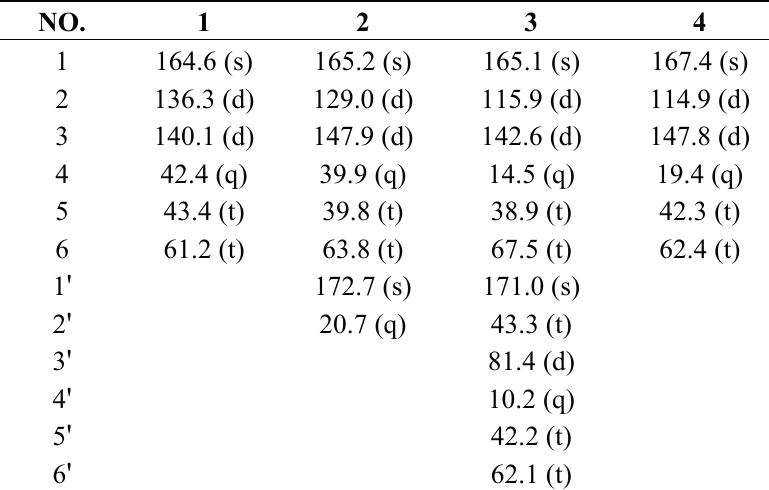
Table 2. 13 C-NMR spectroscopic data of compounds 1 – 4 ( 1 and 2 in CD 3 OD, 3 and 4 in CDCl 3 , 100 MHz).